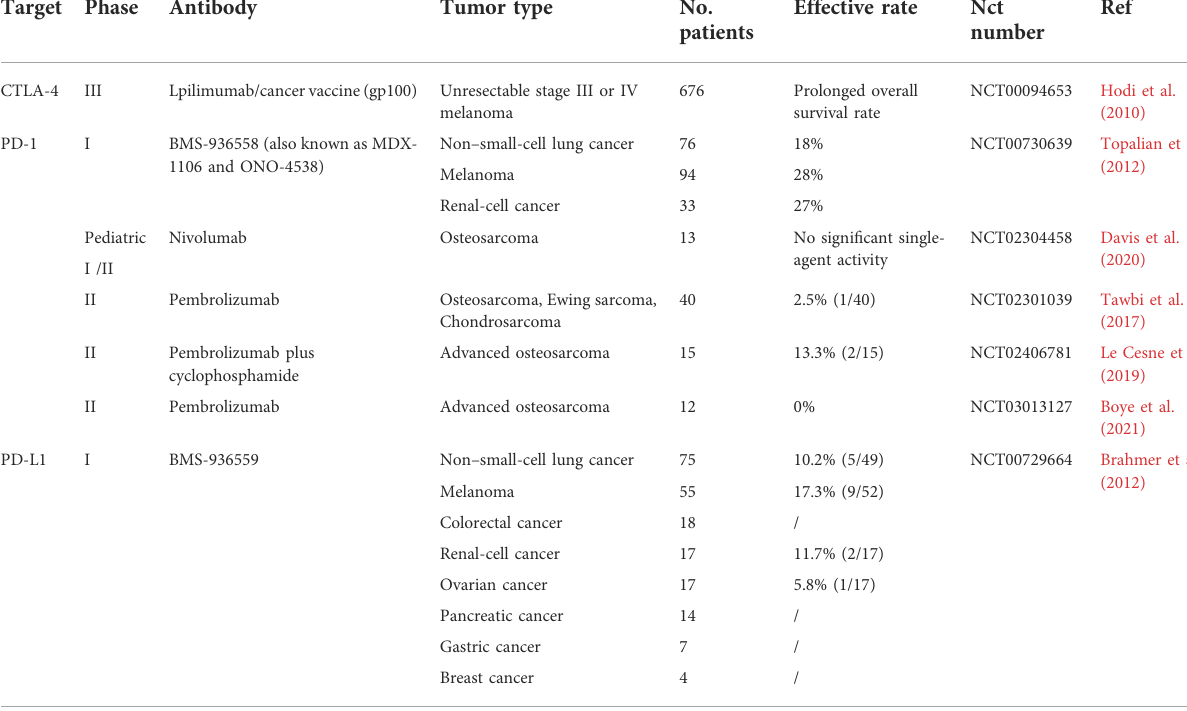
TABLE 3 Clinical trials of CTLA-4 and PD-1/PD-L1 blocking antibodies in human malignancies. Target